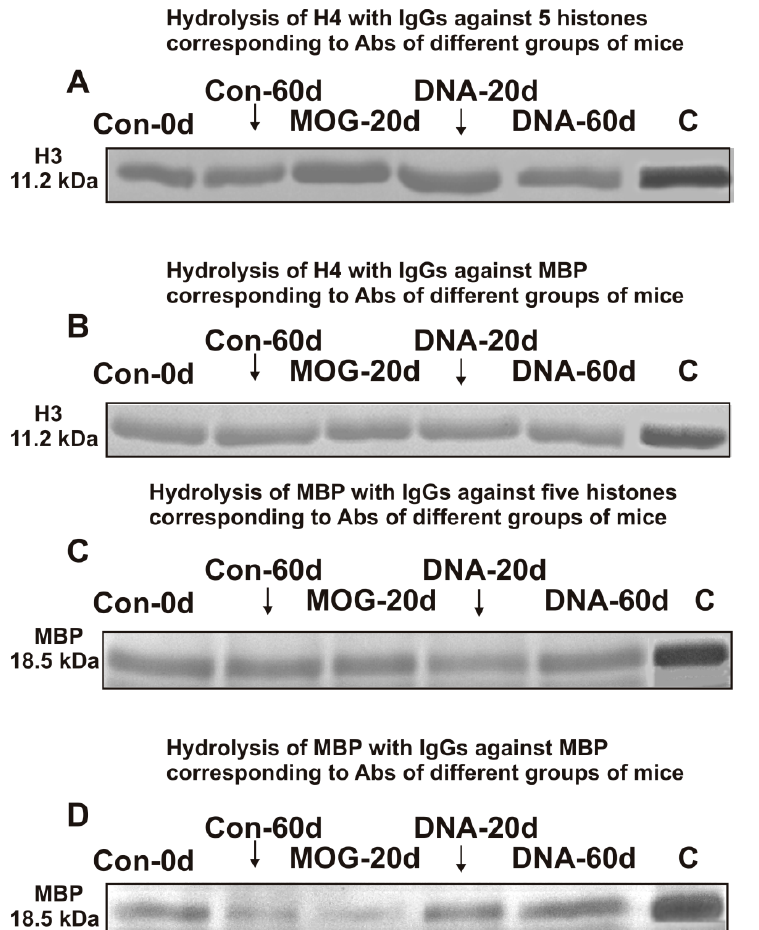
Figure 2. SDS-PAGE analysis of H4 histone hydrolysis by IgG-abzymes against five histones ( A ) and this histone with IgGs against MBP ( B ) as well as splitting myelin basic protein by IgGs against five histones ( C ) and IgG-abzymes against MBP ( D ). Lanes C correspond to the histones ( A ) and MBP ( B ) incubated without IgGs. MBP and a mixture of five histones with and without IgGs (0.03 mg/mL) were incubated for 12 h.